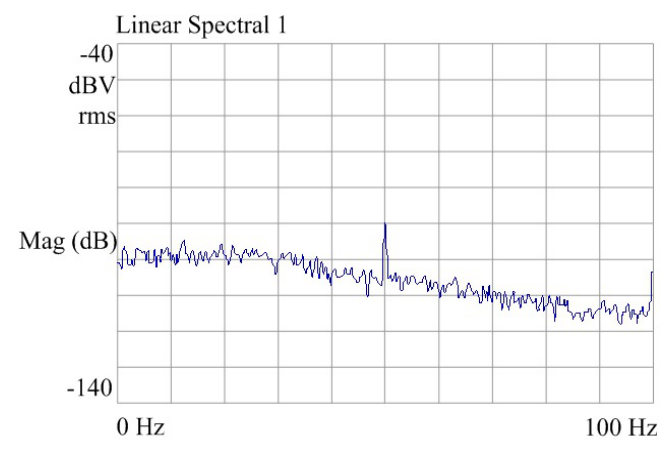
Figure 10. Spectrum of system output noise. Table 3. Test results of the interface circuit for micro gyroscope with ball-disc rotor. Parameters